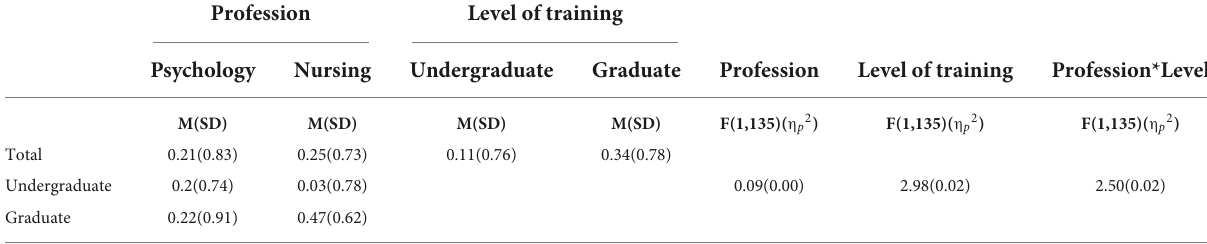
TABLE 3 A 2-way ANOVA for the profession, the level of training, and the profession by the level of training interaction on implicit attitudes ( d-score